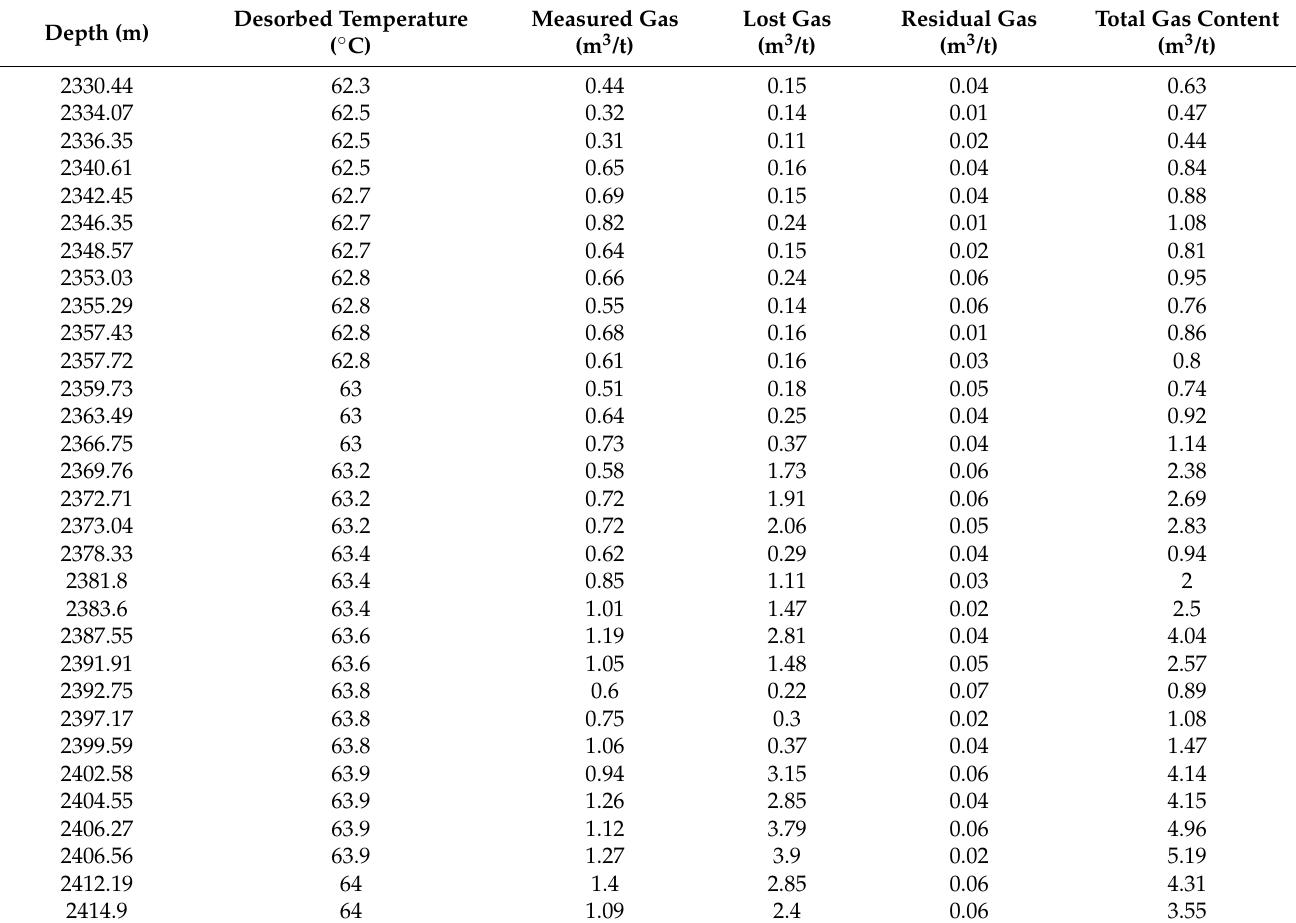
Table 5. Gas content data of Wufeng-Longmaxi Formation in Well